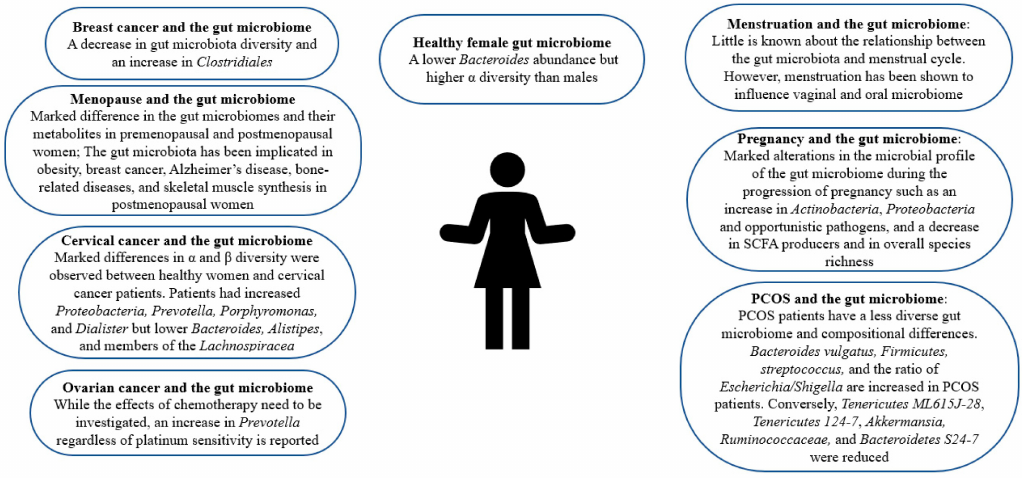
Figure 1. The role of gut microbiome in female